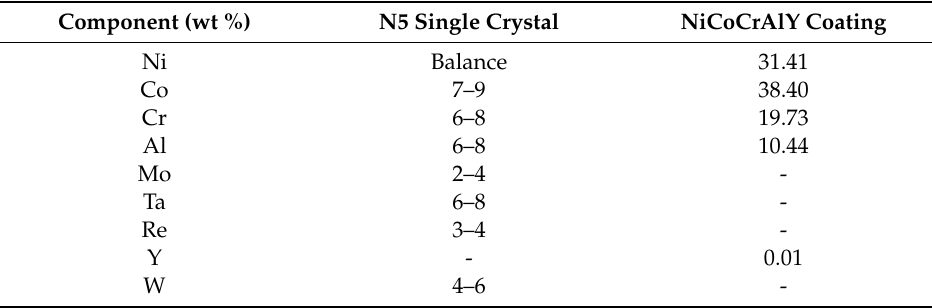
Table 1. Nominal compositions of N5 single crystal superalloy and NiCoCrAlY